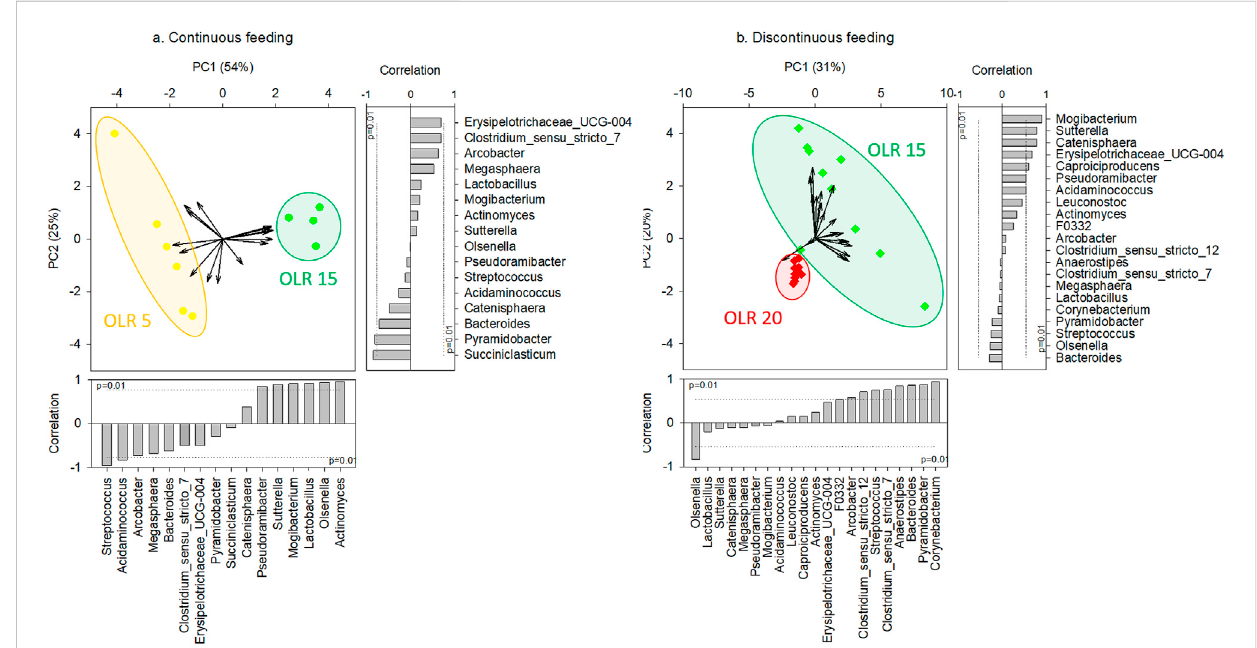
FIGURE 2 Principal Components Analysis (PCA) biplot representing the typifying microbial composition at genus level ( ≥ 5% in at least one sample) in reactors operated at different OLRs under continuous (A) (reactors #1 and #2) and discontinuous (B) feeding strategies (reactors #3, #4, #5, and #6). The vector length is proportional to the correlation between corresponding parameter and the PCA axis 1 and 2. Bar plot shows the contribution of each variable (vector projection values) expressed as the correlation with the x- and y -axis. The genera signi fi cantly correlated with x- and y -axis were the main responsible for the obtained clusterization.